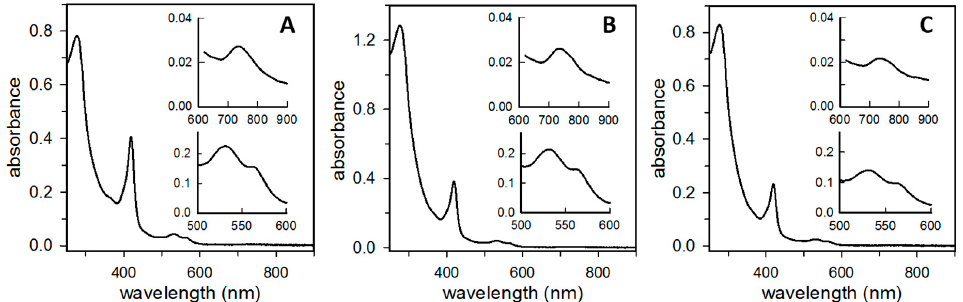
Figure 6. The electronic absorption spectrum of Bfr isolated from P. aeruginosa indicates that heme is axially coordinated by two Met52 residues within BfrB inter-subunit dimers. Spectra shown cor- respond to Bfr isolated from cells cultured ( A ) aerobically, ( B ) micro aerobically in 2% O 2 , and ( C ) anaerobically; the corresponding protein concentrations in mg/mL are 0.7, 0.9, and 0.6. The full spec- tra were obtained in a 0.2 cm path-length cuvette, and the traces in the insets were measured in a 1.0 cm path-length cuvette. The full spectra highlight the characteristic 418 nm Soret bands and the strong feature with absorption maximum ca. 300 nm, which originated from mineralized Fe 3+ in the interior cavity. The bottom insets highlight the α - and β -bands (~560 and ~530 nm), and the top insets highlight the weak 740 nm band characteristic of bis-Met heme ligation in bacterioferritin.